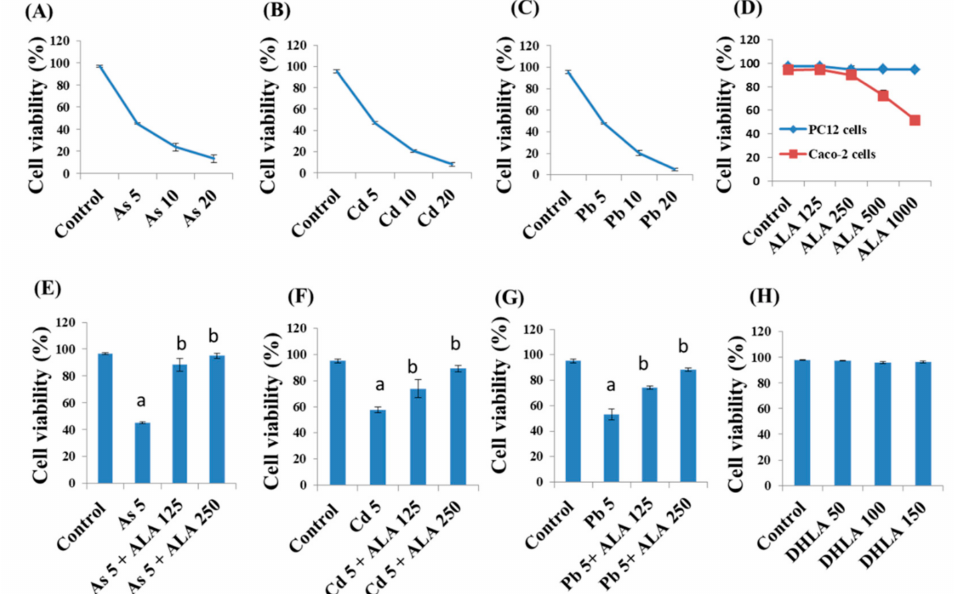
Figure 2. Cell viability of PC12 cells after exposure to toxic metals ( A ) As (0–20 µ M), ( B ) Cd (0–20 µ M), and ( C ) Pb (0–20 µ M) for 48 h of incubation. Cell viability of PC12 cells and Caco-2 cells after exposure to ( D ) ALA (0–1000 µ M) for 48 h of incubation. Cell viability of PC12 cells after exposure to ( E ) As (5 µ M) ( F ) Cd (5 µ M), and ( G ) Pb (5 µ M) and/or ALA (125 and 250 µ M) for 48 h of incubation. ( H ) Cell viability of PC12 cells after exposure to DHLA (0–150 µ M) for 48 h of incubation. The valued of the bars indicate the mean ± standard error of the mean (SEM) ( n = at least 3). Here, “a” denotes a significant difference compared to the control group ( p < 0.05), and “b” denotes a significant difference compared to the associated metal group ( p <